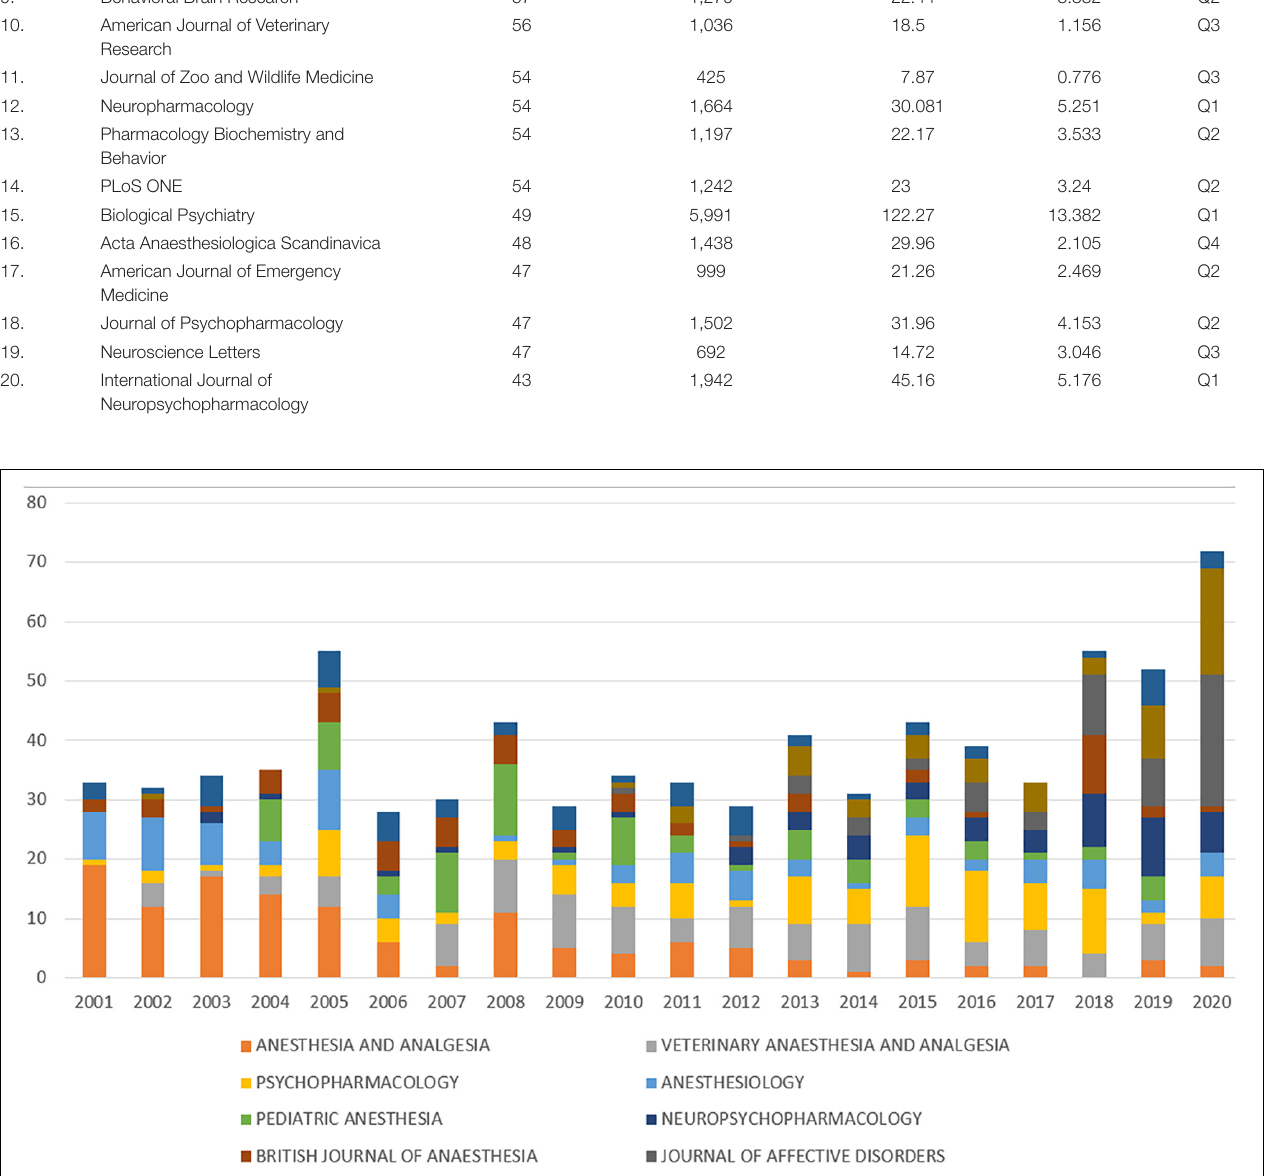
Frontiers in Molecular Neuroscience |